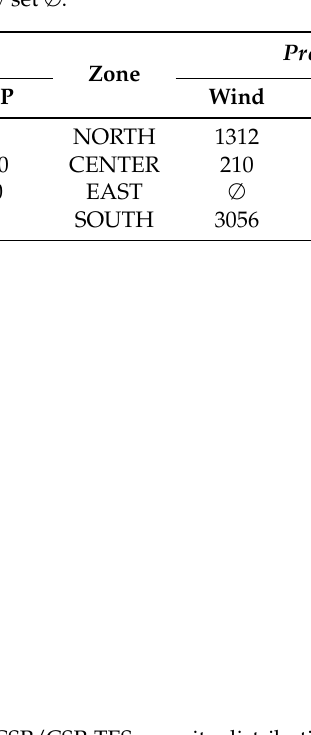
Figure A1. Observed PV, onshore wind and CSP/CSP-TES capacity distribution per electrical zone in Morocco in 2018 corresponding to Table A1 (Left). All CSP/CSP-TES (resp., PV) plants have similar solar multiple of 1.3–1.4 means 30–40% of thermal surplus (resp., inverter loading ratio of 1 means without storage), as shown in Appendix C.2. Contrary to our study, all operational PV plants are using tracking